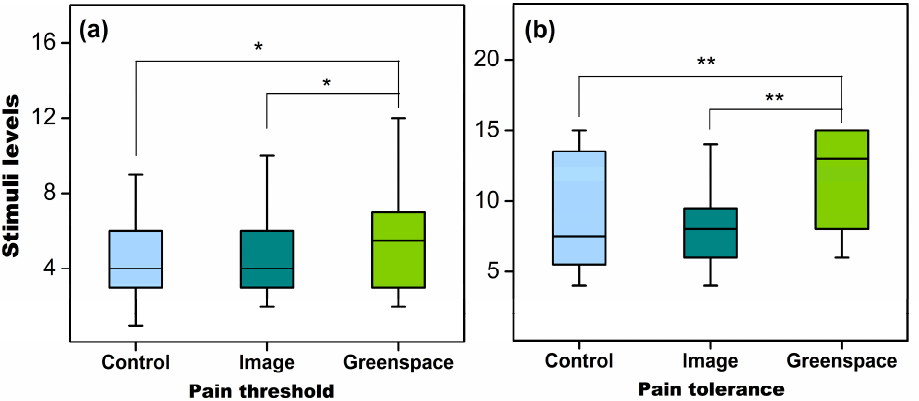
Figure 3. The differences in pain threshold ( a ) and tolerance ( b ) between settings. *, p < 0.05; **, p < 0.01, adjusted by Bonferroni correction.